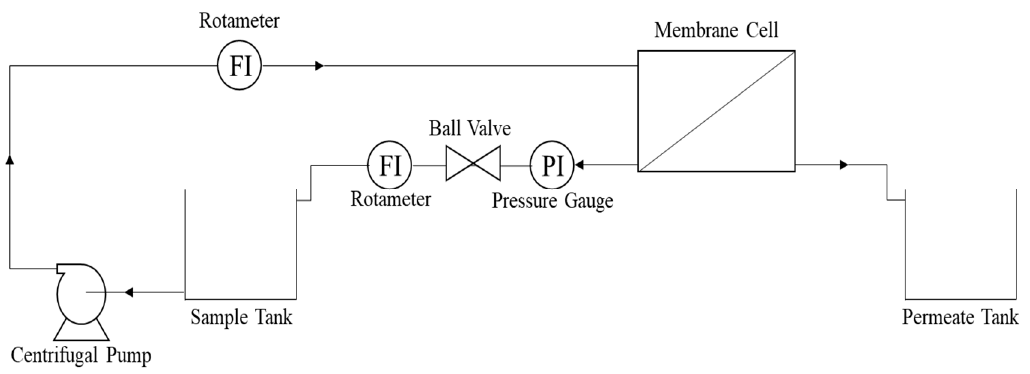
Figure 1. Schematic diagram of the membrane testing unit.